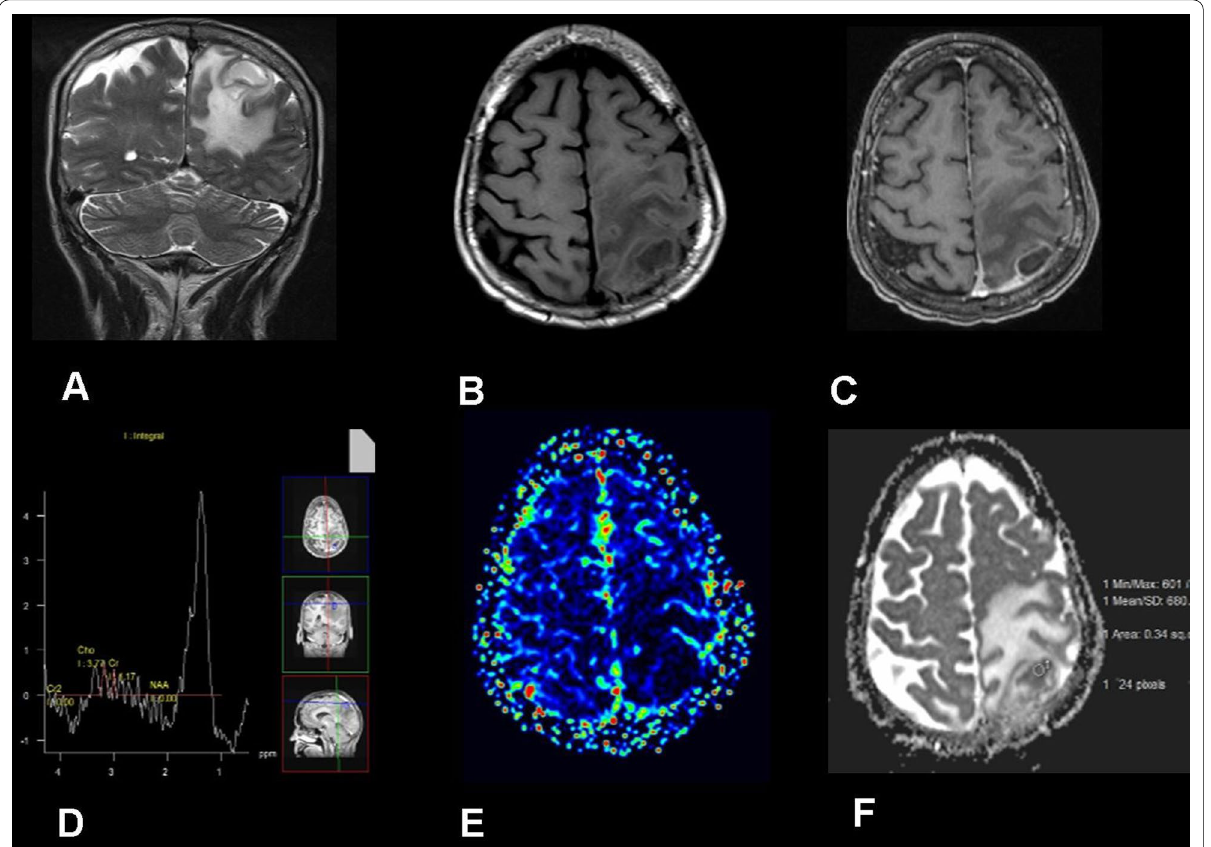
Fig. 5 53-year-old male with severe headache showing left high posterior parietal cystic lesion surrounded by vasogenic edema A , B , C coronal T2, axial T1 and T1 GAD. The lesions show T2 hyper intense core and hypo intense thin rim, T1 hypo intense core and iso intense rim with intense peripheral rim and related meningeal enhancement after contrast administration. D Intermediate echo spectroscopy curve shows relatively depleted Cho, Cr and NAA levels with very high lipid peaks at (0.9–1.3 ppm). E rCBV color perfusion map for the same lesion shows area of relative hypo-perfusion (rCBV 0.4). F ADC image shows evident diffusion restriction (ADC value measures around 0.68 = findings are in favor of pyogenic cerebral abscess. Post-operative data confirmed the